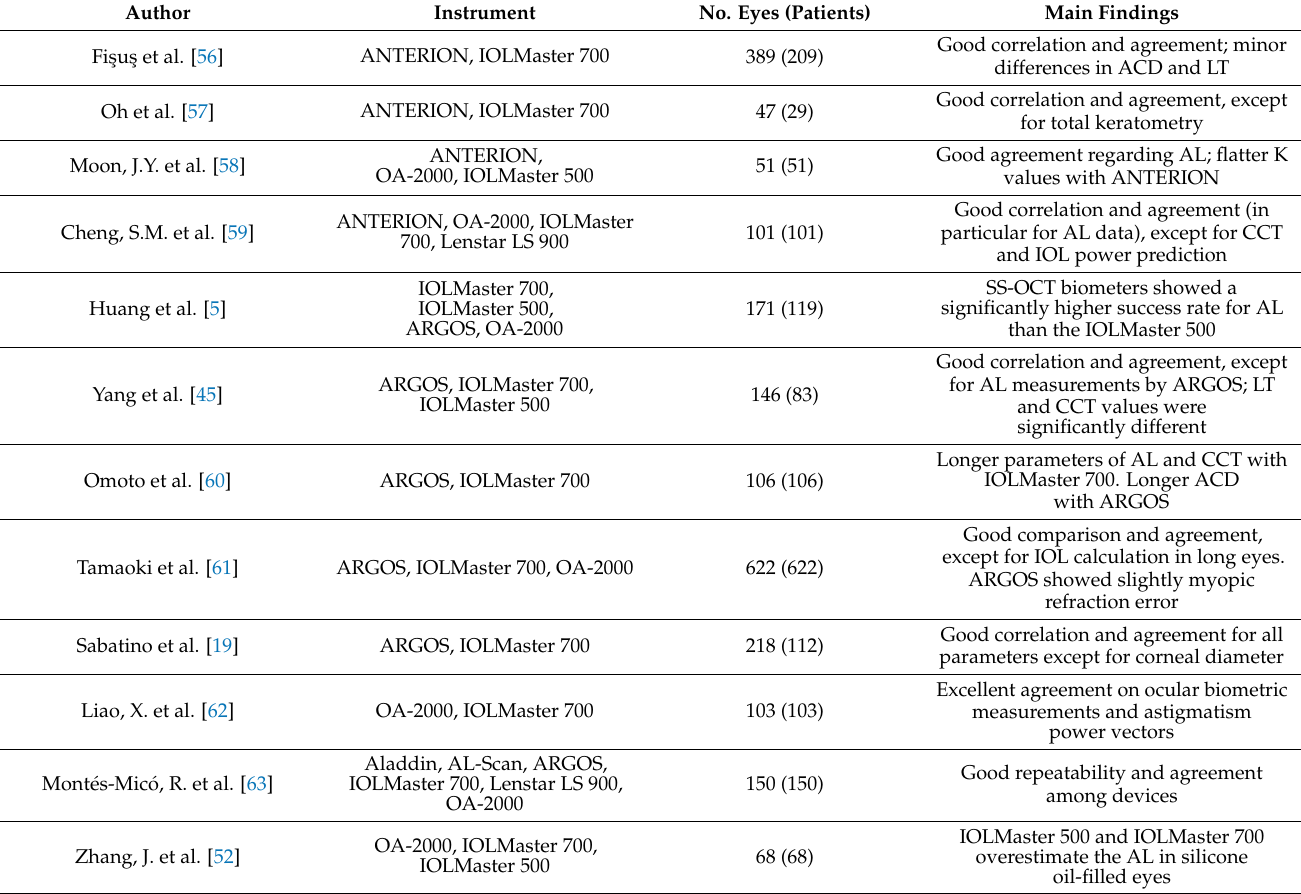
Table 2. Summary of the studies comparing Swept-Source-OCT (SS-OCT)